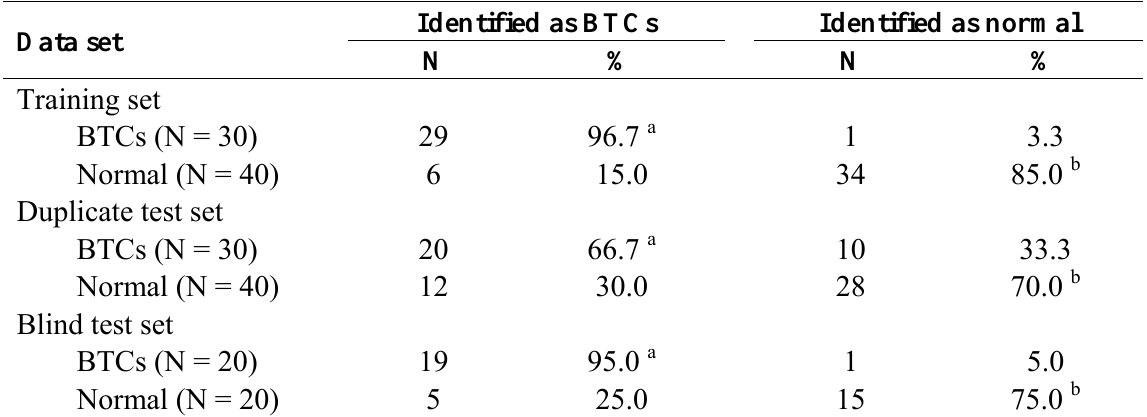
Table 4. Results from the decision tree algorithm in the training, duplicate and blind test